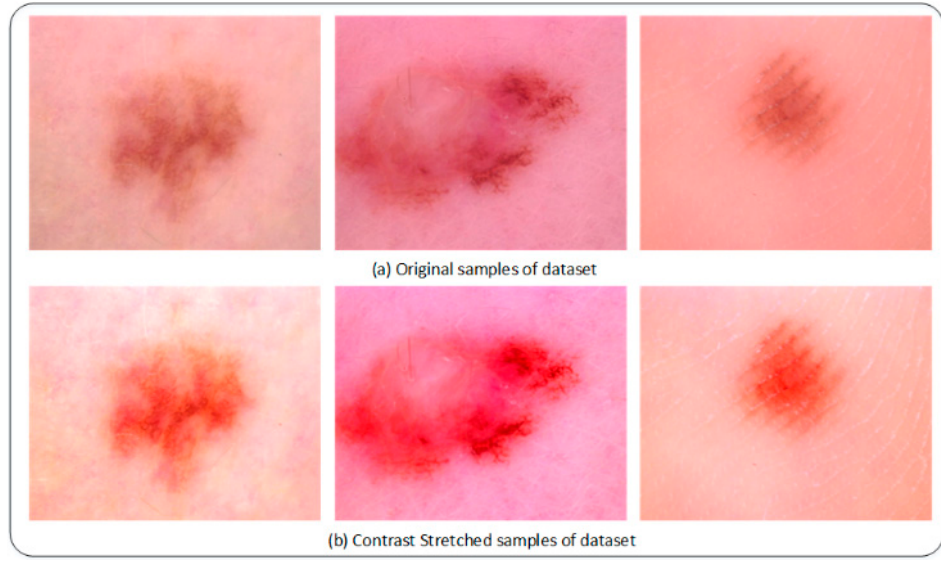
Figure 2. Illustration of contrast-enhanced image; ( a ) original dataset, ( b ) contrasted stretched da- taset. Table 1. A detailed description of the dataset.